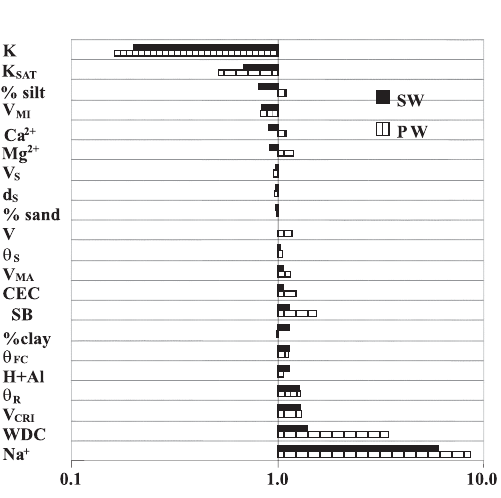
Figure 1. Ratios between soil properties values in non-irrigated soil (plot C) and in soil irrigated with sewage wastewater water (SW) and potable water (PW) chemical properties (H + Al, Na + , K + , Ca 2+ , Mg 2+ , CEC, , SB, V), (b) correlations among physical properties (V S V , V , V , d , θ , θ , θ , WDC, K , % clay, MA MI CRI S R FC S SAT % silt, % sand), and (c) correlations between physical and chemical properties.